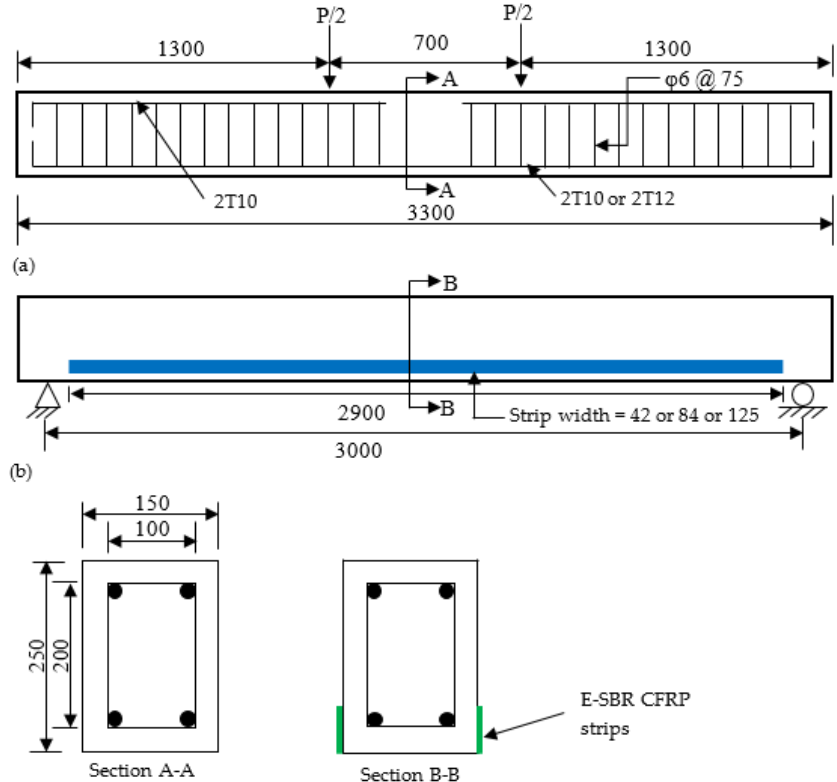
Figure 1. Detailing of the beam specimens (dimensions are in mm). ( a ) control beam; ( b ) strength- ened beam.